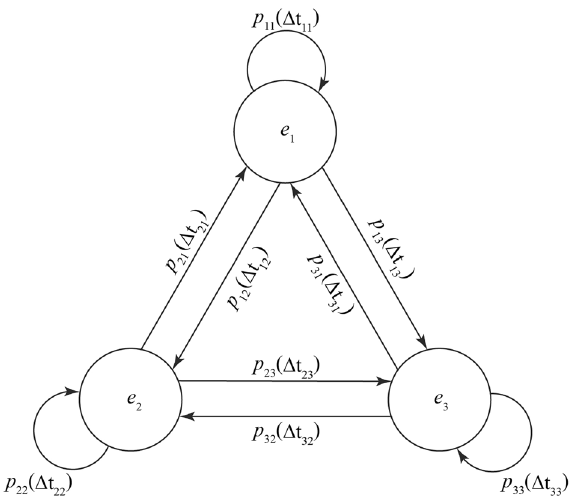
Figure 4. Ventilation system state transition schematic